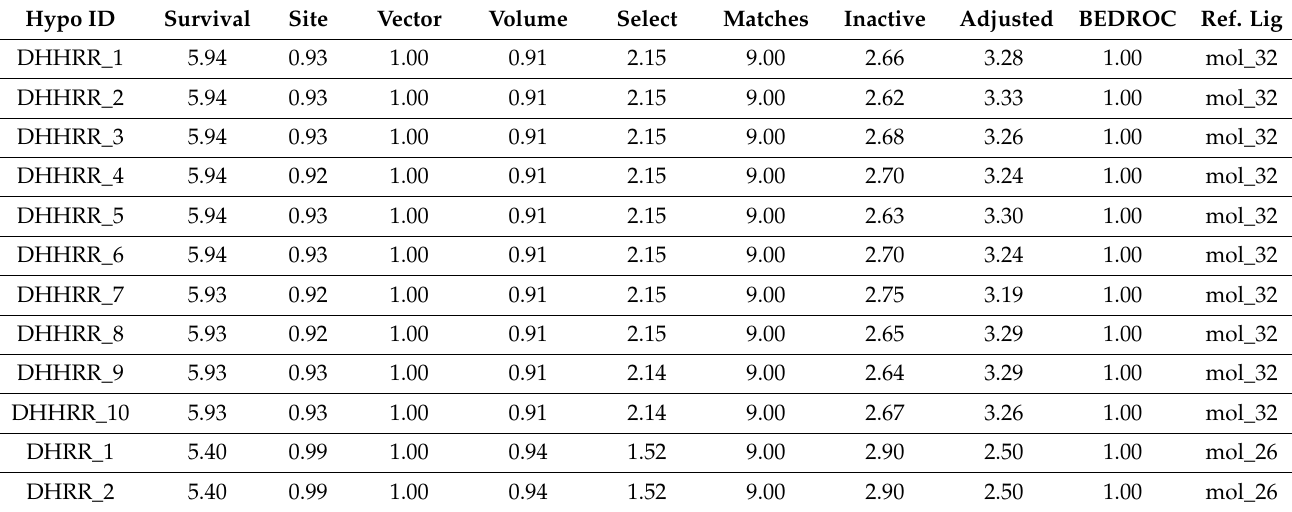
Table 2. Different pharmacophore hypotheses generated by using the compounds and their activity. Hypo